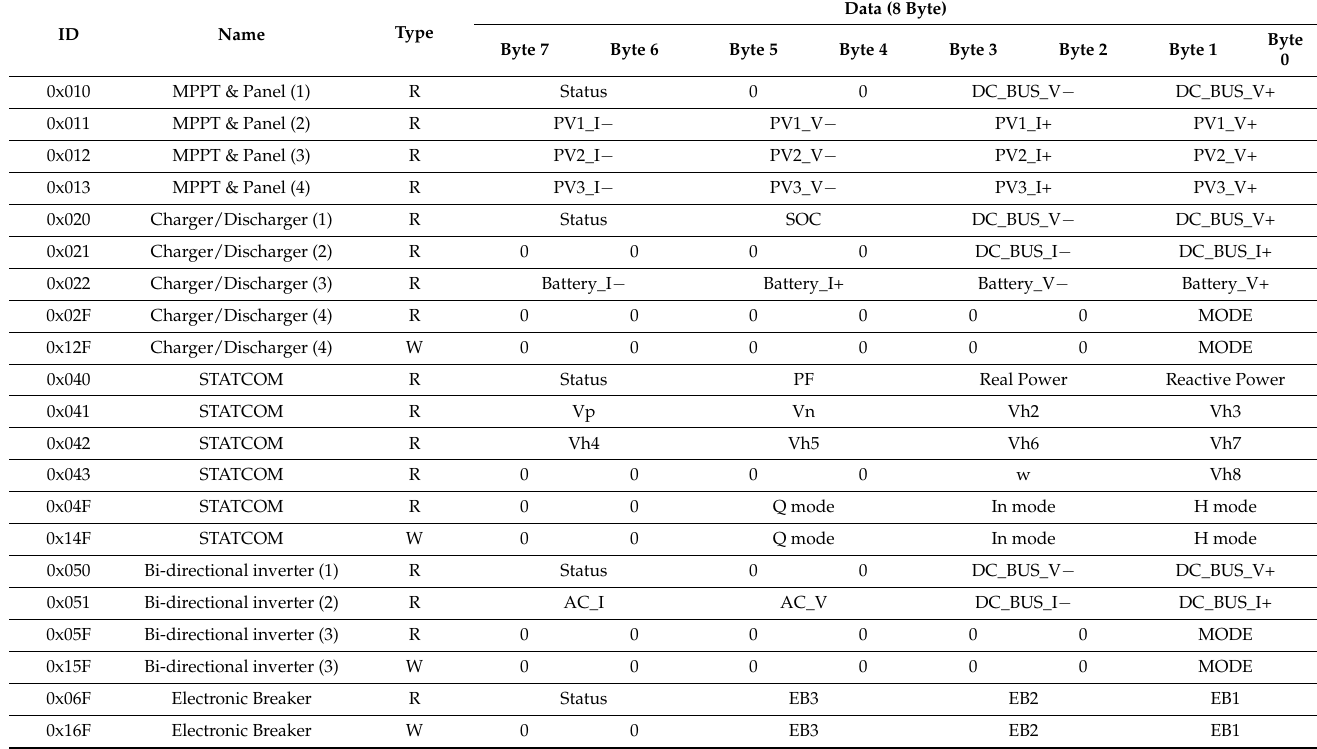
Table 4. The data protocol with CAN bus interface.